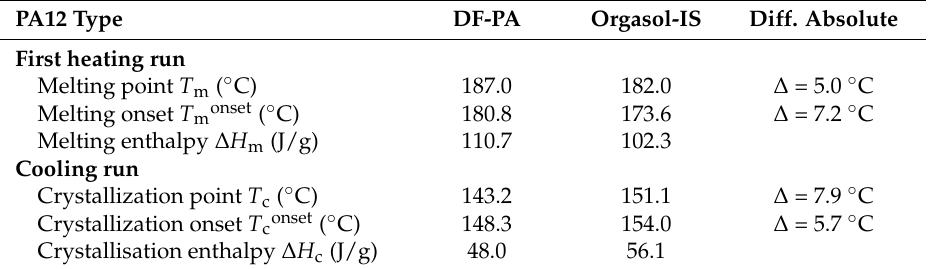
Table 1. Thermal transition points ( T m , T monset , T c , T conset ) and corresponding enthalpies ( Δ H m , Δ H c ).